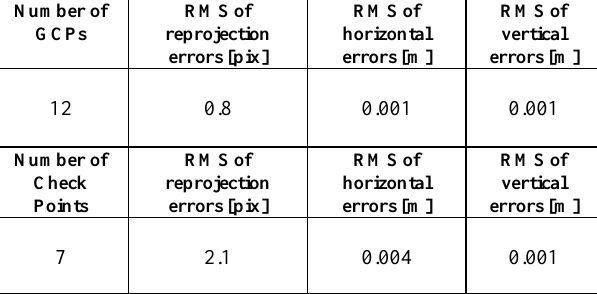
Table 1. Accuracy achieved with the front-facing